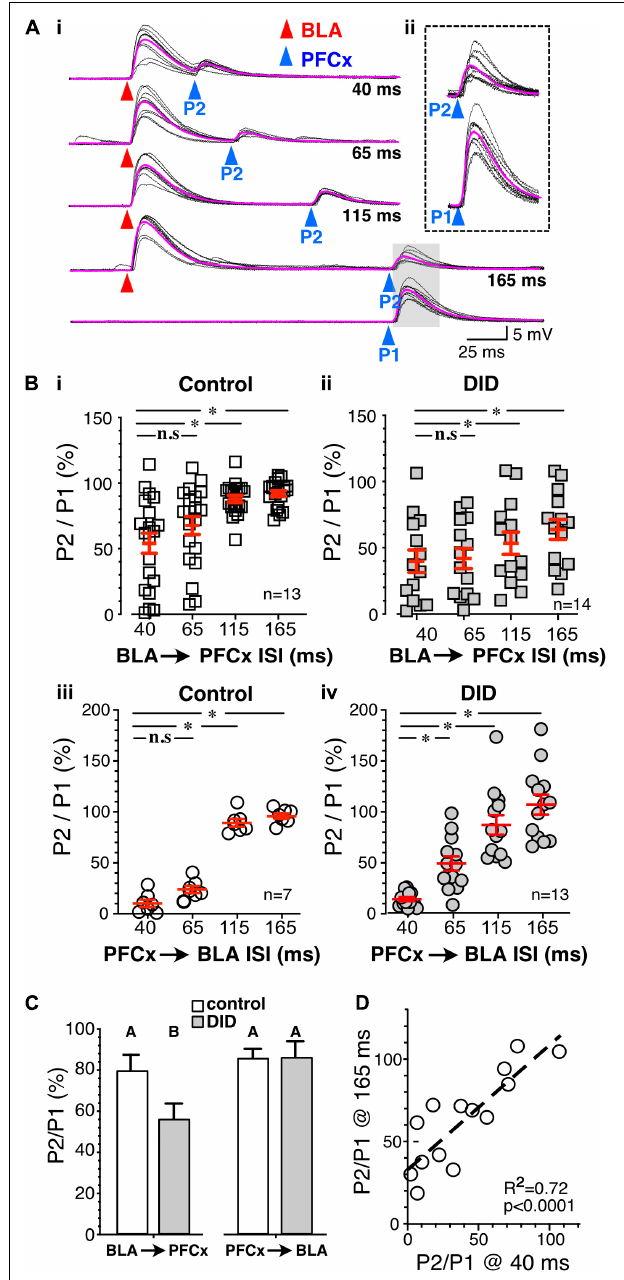
FIGURE 6 | Binge drinking strengthens BLA-driven inhibition of PFCx inputs. (Ai) Ten overlaid traces of PFCx-evoked EPSPs (blue arrowheads) in absence (P1-bottom panel) or presence of BLA-EPSPs (red arrowheads) in the same MSN from an EtOH drinking mouse. Purple traces show average EPSPs. (Aii) Enlarged PFCx-EPSPs traces (P2) evoked 165 ms after BLA-EPSPs or in its absence (P1) as shown in shaded area in panel (Ai) . Note the persistent gating at 165 ms interval indicated by the vertical arrow. (Bi,ii) Magnitude of gating of BLA → PFCx inputs in water-drinking (Control) and Drinking-in-the-Dark mice (DID) at various intervals relative to control expressed as percent relative to control (P1) in 13 and 14 MSNs, respectively. (Biii,iv) Magnitude of gating of PFCx → BLA inputs in water-drinking mice (Control) and Drinking-in-the-Dark mice (DID) at various intervals relative to control in 7 and 13 MSNs, respectively. (Continued)